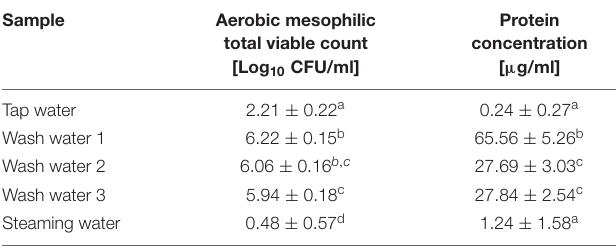
TABLE 6 | Aerobic mesophilic total viable count and protein concentration of the process water along the processing chain of cricket flour.